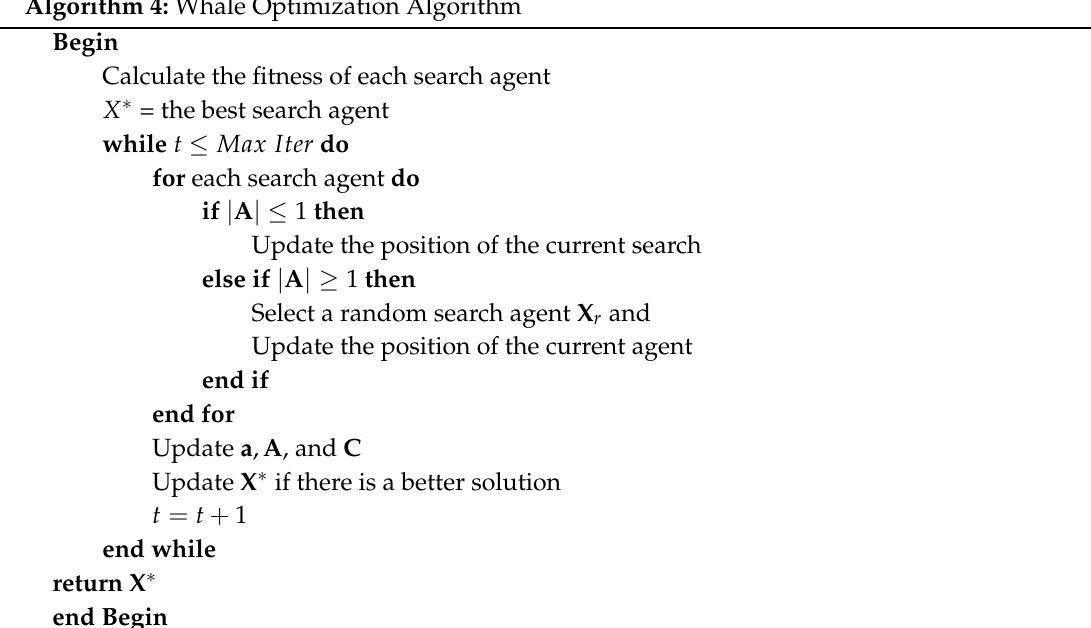
Algorithm 4: Whale Optimization